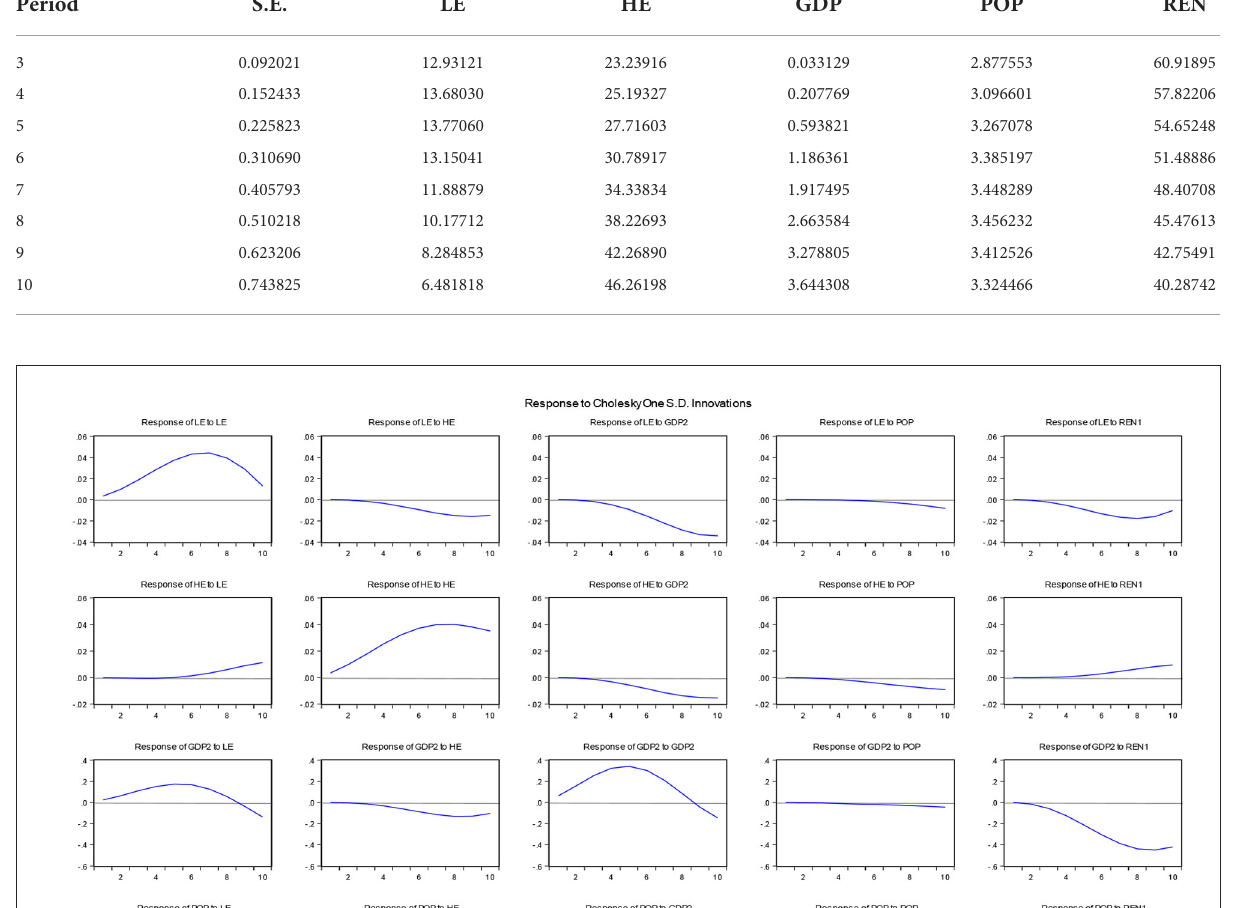
FIGURE4 Impulse response results.